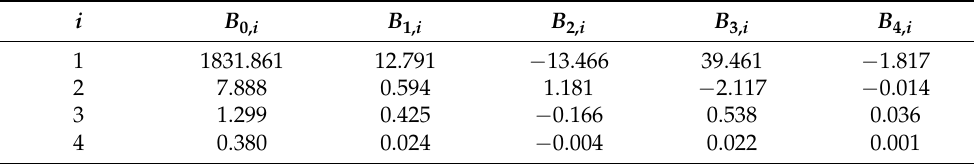
Table 16. Coefficients of multivariate linear regression analysis (excluding abnormal